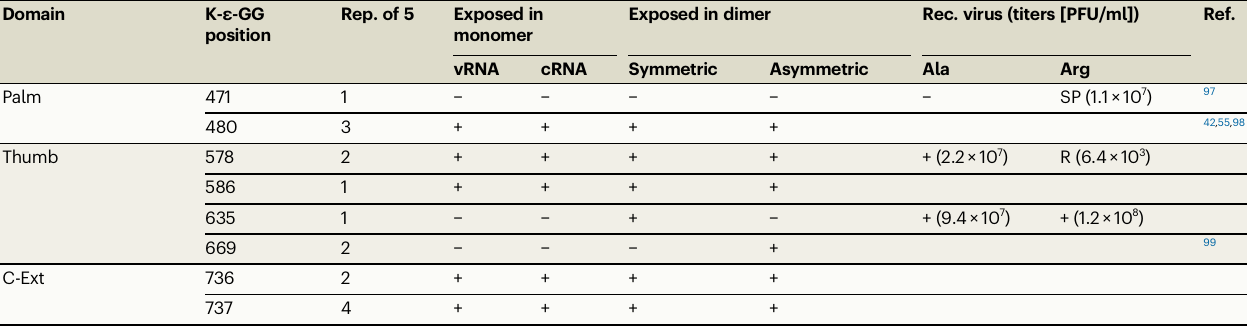
ListofthepositionsofallK- ε -GGboundlysinesinthePB2,PA,andPB1subunitsdetectedin5independentreplicates(Rep.)at5hp.i.togetherwiththeirlocationinfunctionaldomains.Thenumberof replicatesinwhichthesitewasdetectedisindicated(Rep.of5).Surfaceexposureoftheidenti fi edsiteswasassessedusing3DstructuralmodelsofaWSN-adaptedIAVpolymerasemonomerbound toeithervRNAorcRNAaswellasthe3DstructuresofthesymmetricdimeroftheH3N2polymerase(PDB:6QNW)andtheANP32A-stabilizedasymmetricdimerofthein fl uenzaCviruspolymerase. Surfaceexposureisindicatedwith(+),concealedlocationisindicatedwith( − ).Intheasymmetricdimer,surfaceexposureisalsoitemizedregardinglocationinthereplicating(Rep)orencapsidating (Enc)polymerase.Successorfailuretogeneraterecombinantviruseswiththeplasmidsencodingtherespectivemutationsafterthreeindependentrescueattemptsisencodedby(+)=generationof virus,( − )=novirusafterthreeattempts,(R)=generationofvirusbutreversiontowildtype,(SP)=generationofvirusbutsmallplaquephenotype,(LT)=generationofvirusbutlowrescuetiter.Rescue titers areprovided as [PFU/ml]. Studies that havepreviously described orfunctionally characterized the detected lysines arelistedinthe references(Ref.)